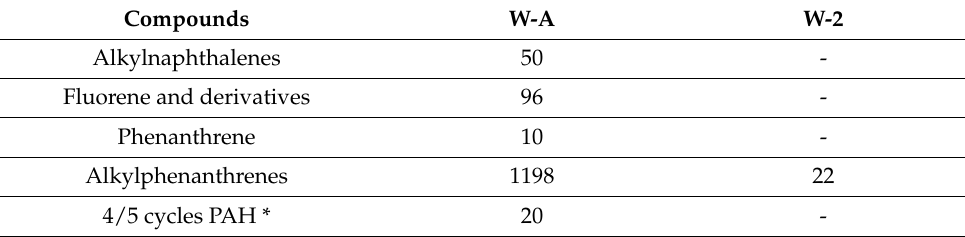
Table 11. Concentrations of PAH in surface soils immediately after a wildfire (W-A) and two years after a wildfire (W-2), µ g/kg. Data from [107]. Compounds W-A W-2 Alkylnaphthalenes 50 -